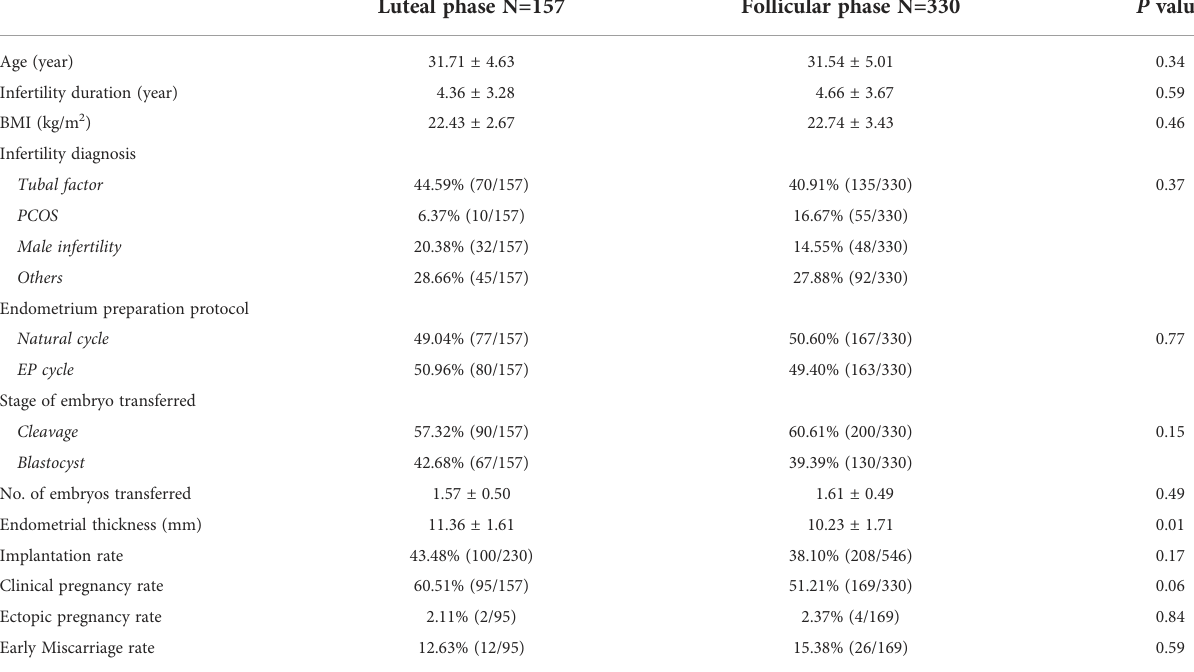
TABLE 1 Basic parameters and pregnancy outcomes in patients undergoing endometrial injury in two